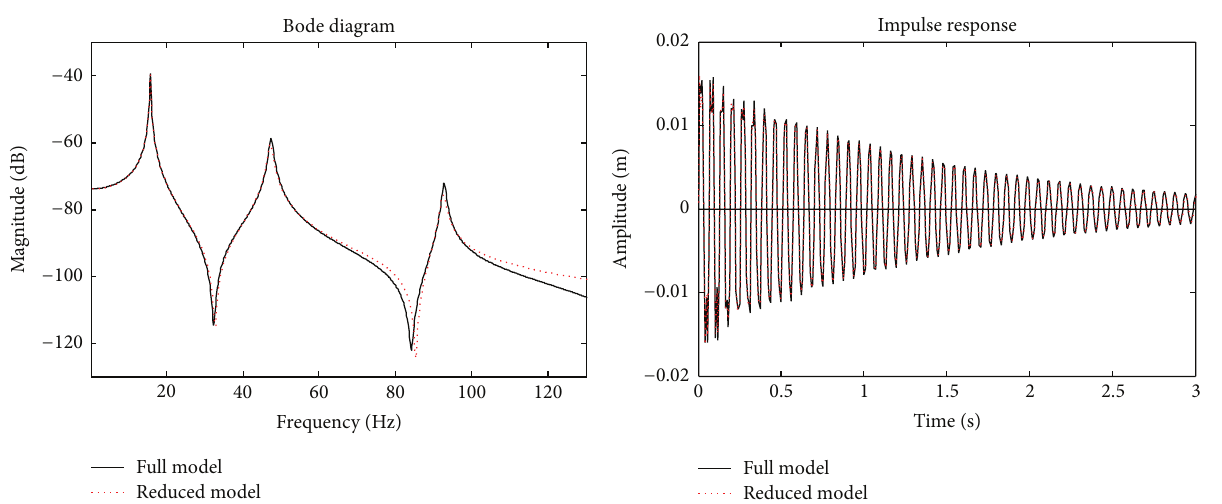
Figure 5: The frequency and time domain responses of the original and reduced model of the ACLD/plate.